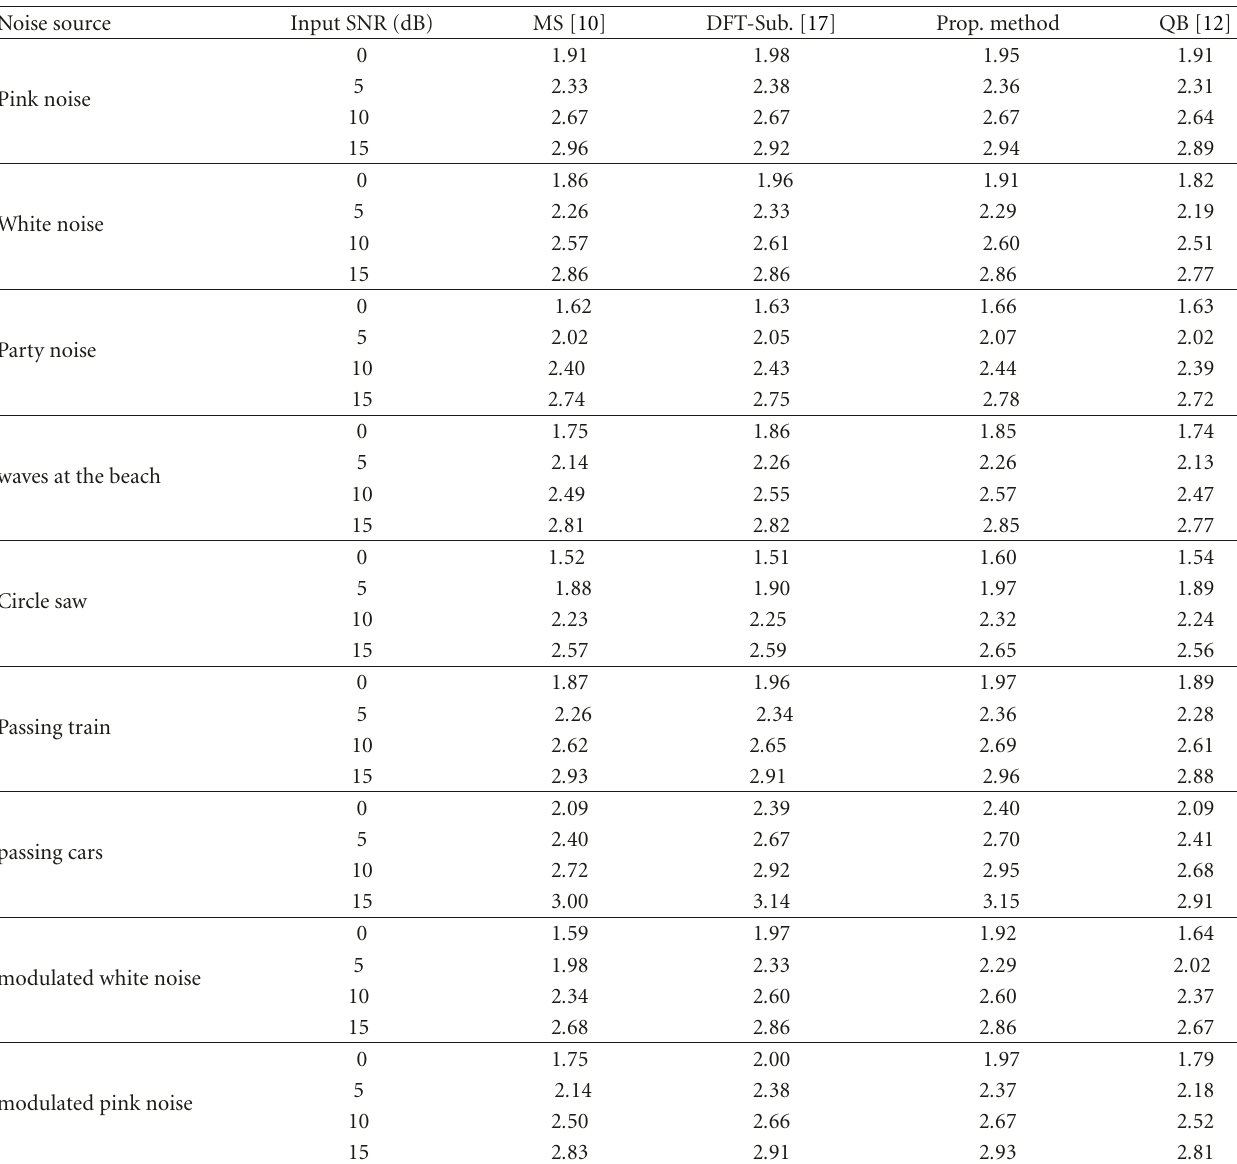
Table 4: Performance in terms of